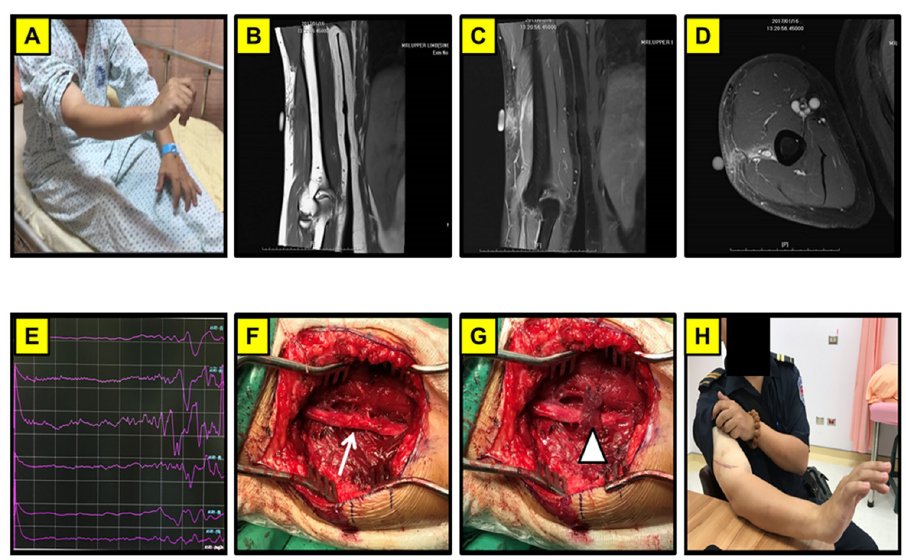
Fig 2. Representative right radial nerve injury by a crush injury with chronic denervation. (A) A 38-year-old male suffered a crush injury with the paralysis of finger dorsal flexion for 6 months. (B) MRI of right upper limb in T1W1 in coronal axial view. (C) MRI of right upper limb in T1W1 with contrast administration in coronal view. (D) MRI of right upper limb in T1W1 with contrast administration in axial view. (E) Intraoperative recording of CMAP in brachioradials and dorsal digitorum of radialis. (F) Intraoperative photography showing nerve crushed injury. (G) The injured nerve wrapped by the biceps muscle. (H) The patient showed the improved neurological outcome with restoration of wrist function 2 months after the operation. Arrow: radial nerve in the crush site; Arrow head: muscle flap rotation.